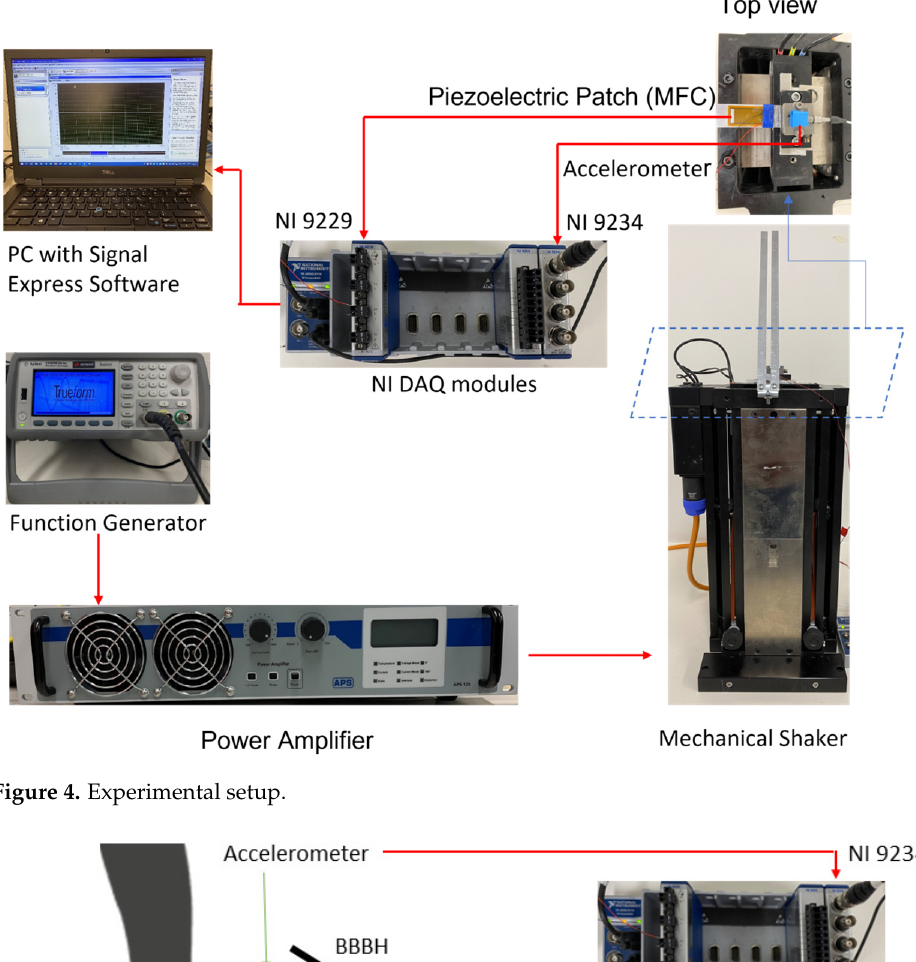
Figure 4. Experimental setup.